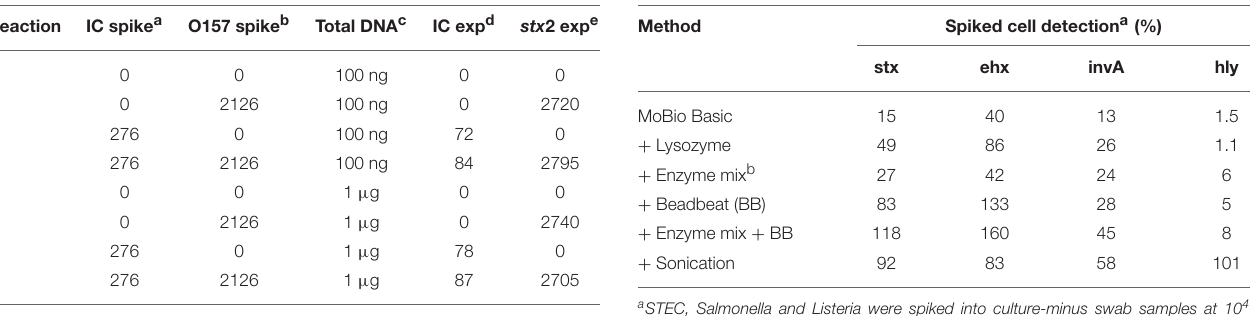
TABLE 2 | The effect of DNA levels on IC and stx 2 detection. TABLE 3 | Extraction method